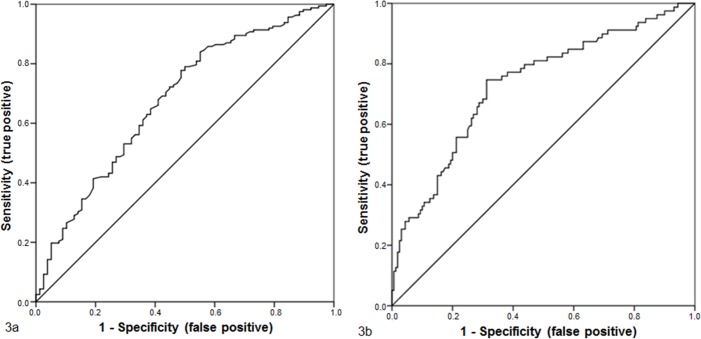
Figs 3a and 3b: The ROC analysis. The results of the ROC analysis show the significant effect of the ISD on vaginal breech delivery success. The AUC was 67.7%, and the regression equation was 8,164–0.818*ISD (Fig 3a). The AUC was 73.1% when maternal age was included in the ROC analysis. The regression equation was 2.949–0.859*ISD+0.193*mother’s age at delivery (Fig 3b).